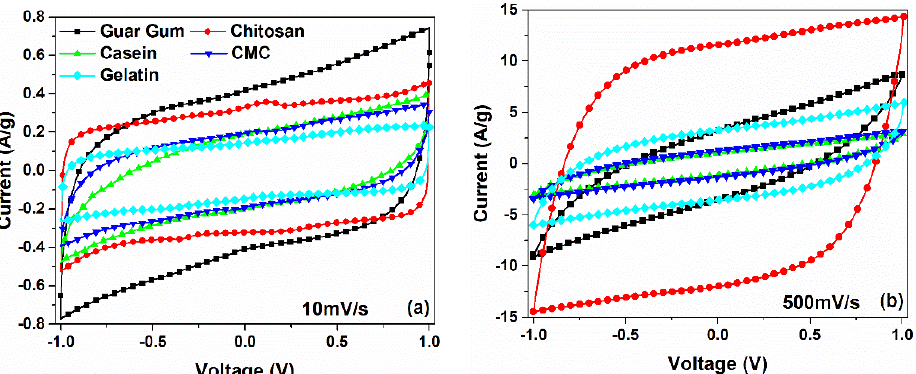
Figure 2. Cycle voltammetry curves of symmetric carbon-based supercapacitors investigated in 1 M NaCl electrolytes measured at ( a ) 10 mV/s and ( b ) 500 mV/s, respectively. By taking into account Equation (1), the gravimetric capacitance ( C S ) can be calculated from the CV curves. Figure 3 displays the values of C S as a function of the voltage scan rates, which range from 10 to 500 mV s − 1 . Here, the capacitance values decrease with the increase of the scan rate. At a lower scan rate region ( υ ≤ 50 mV/s) the ions have sufficient time to diffuse into the pores of activated carbon at the electrode/electrolyte interface, leading to their accumulation. This phenomenon leads to the formation of a double layer charged at the electrodes, characterized by a capacitance C S . As can be observed in Figure 3, the highest value of the C S , which is 82.2 F/g at 10 mV/s, is obtained for C S having the guar gum as a binder in the electrodes. By increasing the scan rate the C S value decreases down to 11.9 F/g at 500 mV/s, corresponding to a reduction of 85.6%. Moreover, the device fabricated with chitosan shows a value of 63 F/g at 10 mV/s that decreases only by 37.8%, reaching a stable value of 39.1 F/g at 500 mV/s. The other binders (e.g., casein, CMC, and gelatin) show values of the specific capacitance between 30 and 36 F/g at 10 mV/s that decrease down to 3.8 and 11.6 F/g at 500 mV/s.